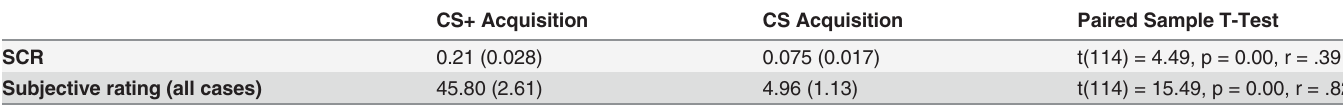
Table 5. CS+ compared to the CS- following Acquisition using SCR and subjective distress ratings (means and bootstrapped standard errors).